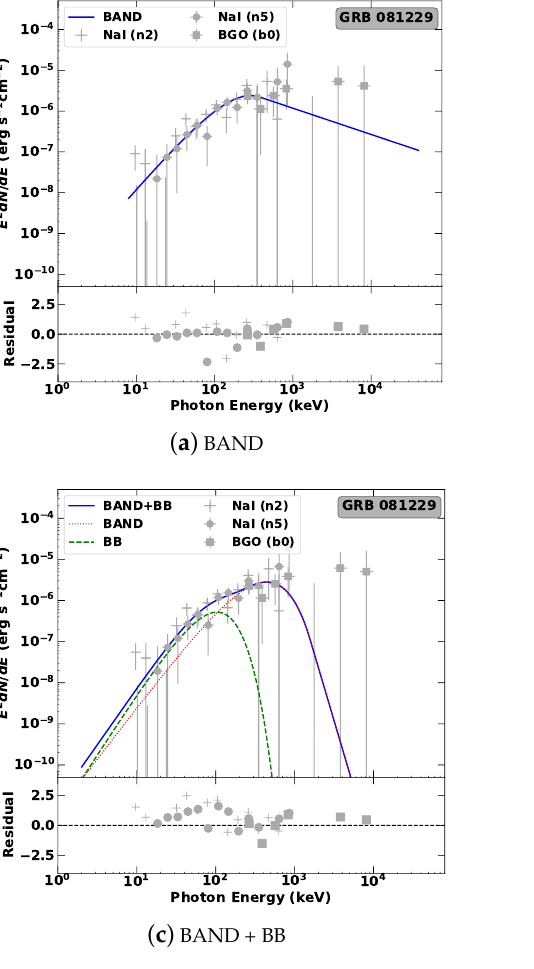
Figure 4. Spectral-fitting results for one GRB in class (i) that with R > 0.1 in both of the BAND + BB model and the CPL + BB model, such as GRB